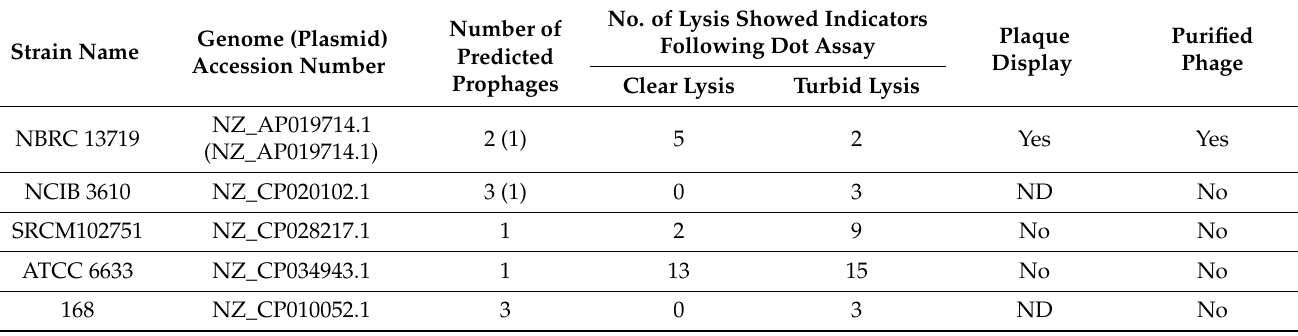
Table 3. The prevalence of UV-light inducible prophages in 5 B. subtilis .